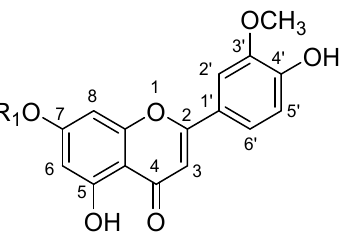
Figure 1. Structures of all flavones identified in weld ( R. luteola ). Numbers in bold, refer to peak numbers in Figure 2; tr1 & tr2 = two trace flavones not visible in Figure 2; glu = β - D -glucopyranoside.